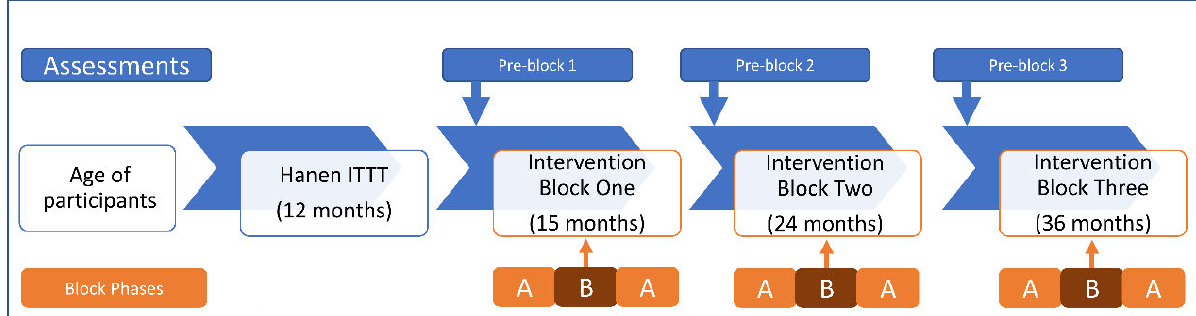
Figure 1. Study phases and timeline.